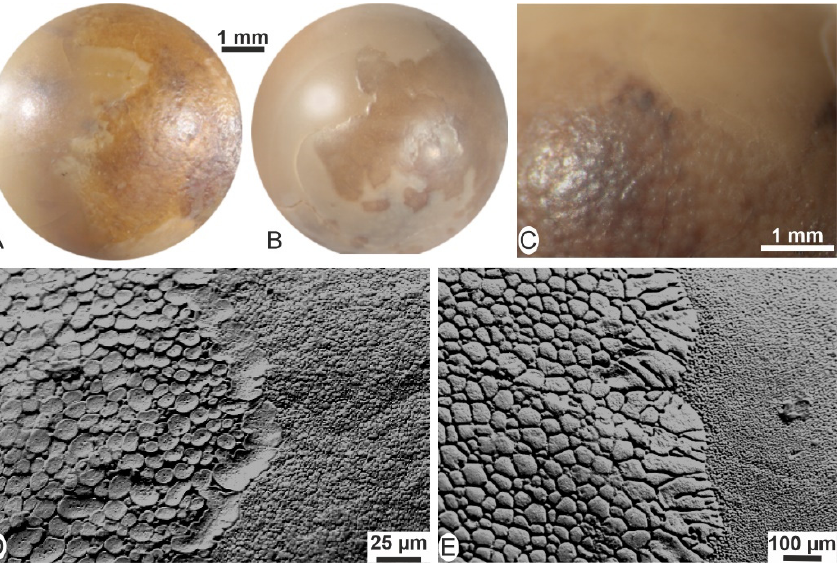
Figure 1. Morphology of the first pearl layer deposits onto nucleus surface. ( A , B ) Optical view of the outer surface showing heterogeneity of the mineral deposits and difference between the two samples. ( C ) Detail showing the irregular surface of 30 ‐ day post ‐ grafting pearl layer. ( D , E ) SEM images of the surfaces of the early pearl layer evidencing heterogeneity of the mineral depositions. Now, high ‐ resolution synchrotron ‐ based methods enable exploration of these un ‐ expectedly complex mineral structures with unprecedented accuracy. Here we report